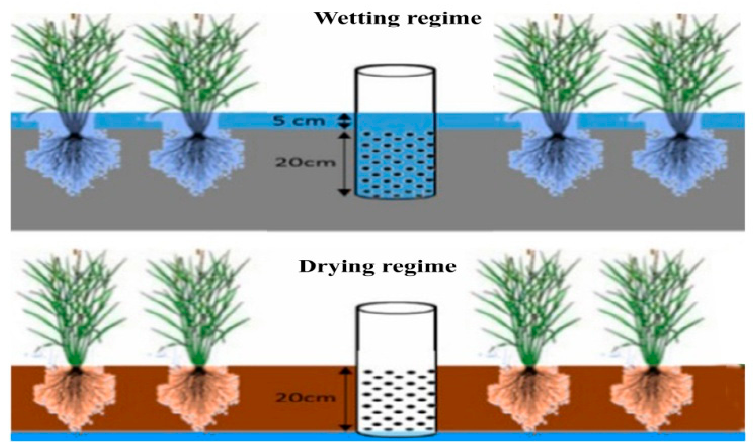
Figure 1. Wetting and drying regimes during the AWD irrigation